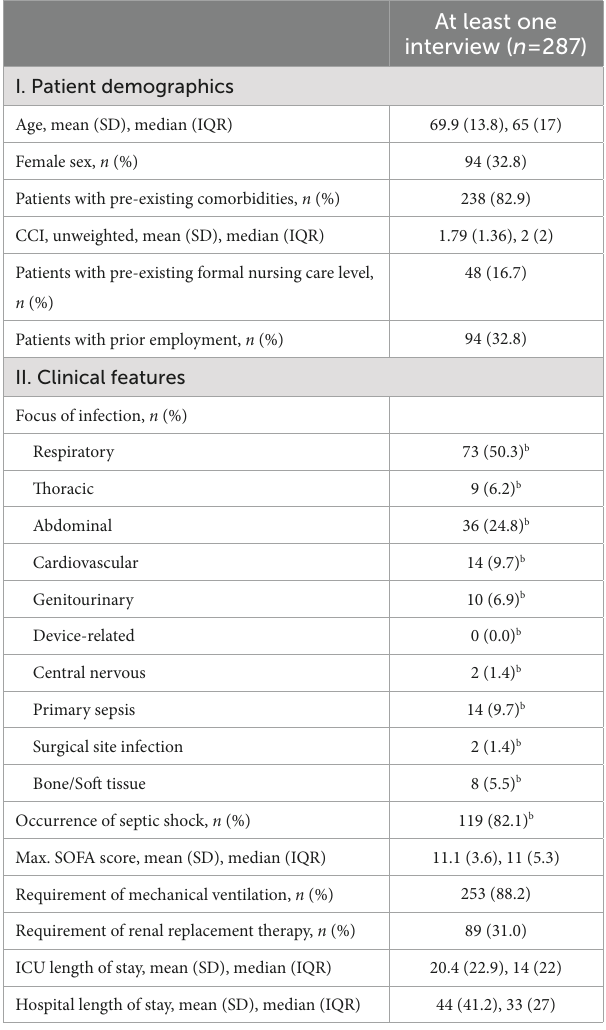
TABLE 1 Patient demographics and clinical features.